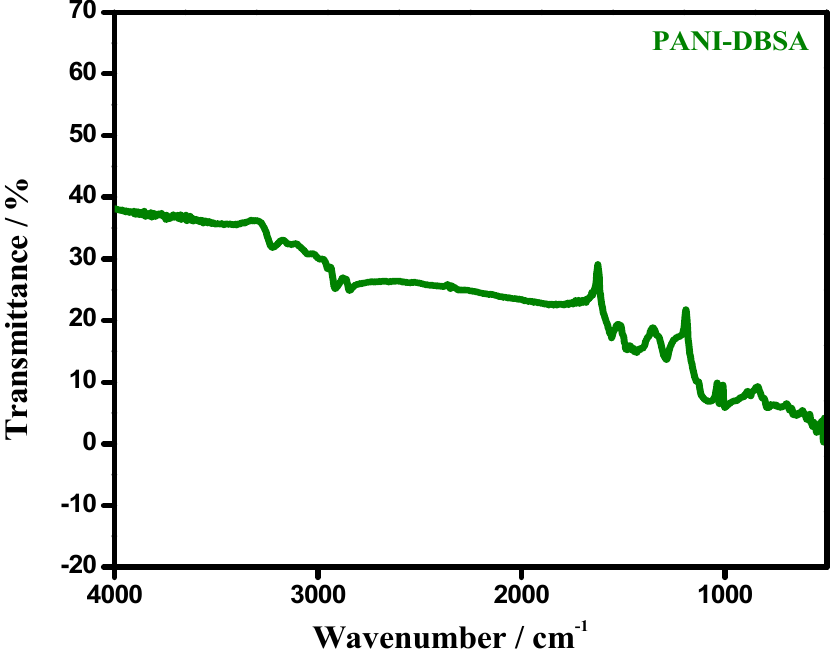
Figure 1. FTIR spectrum of the synthesized polyaniline (PANI).